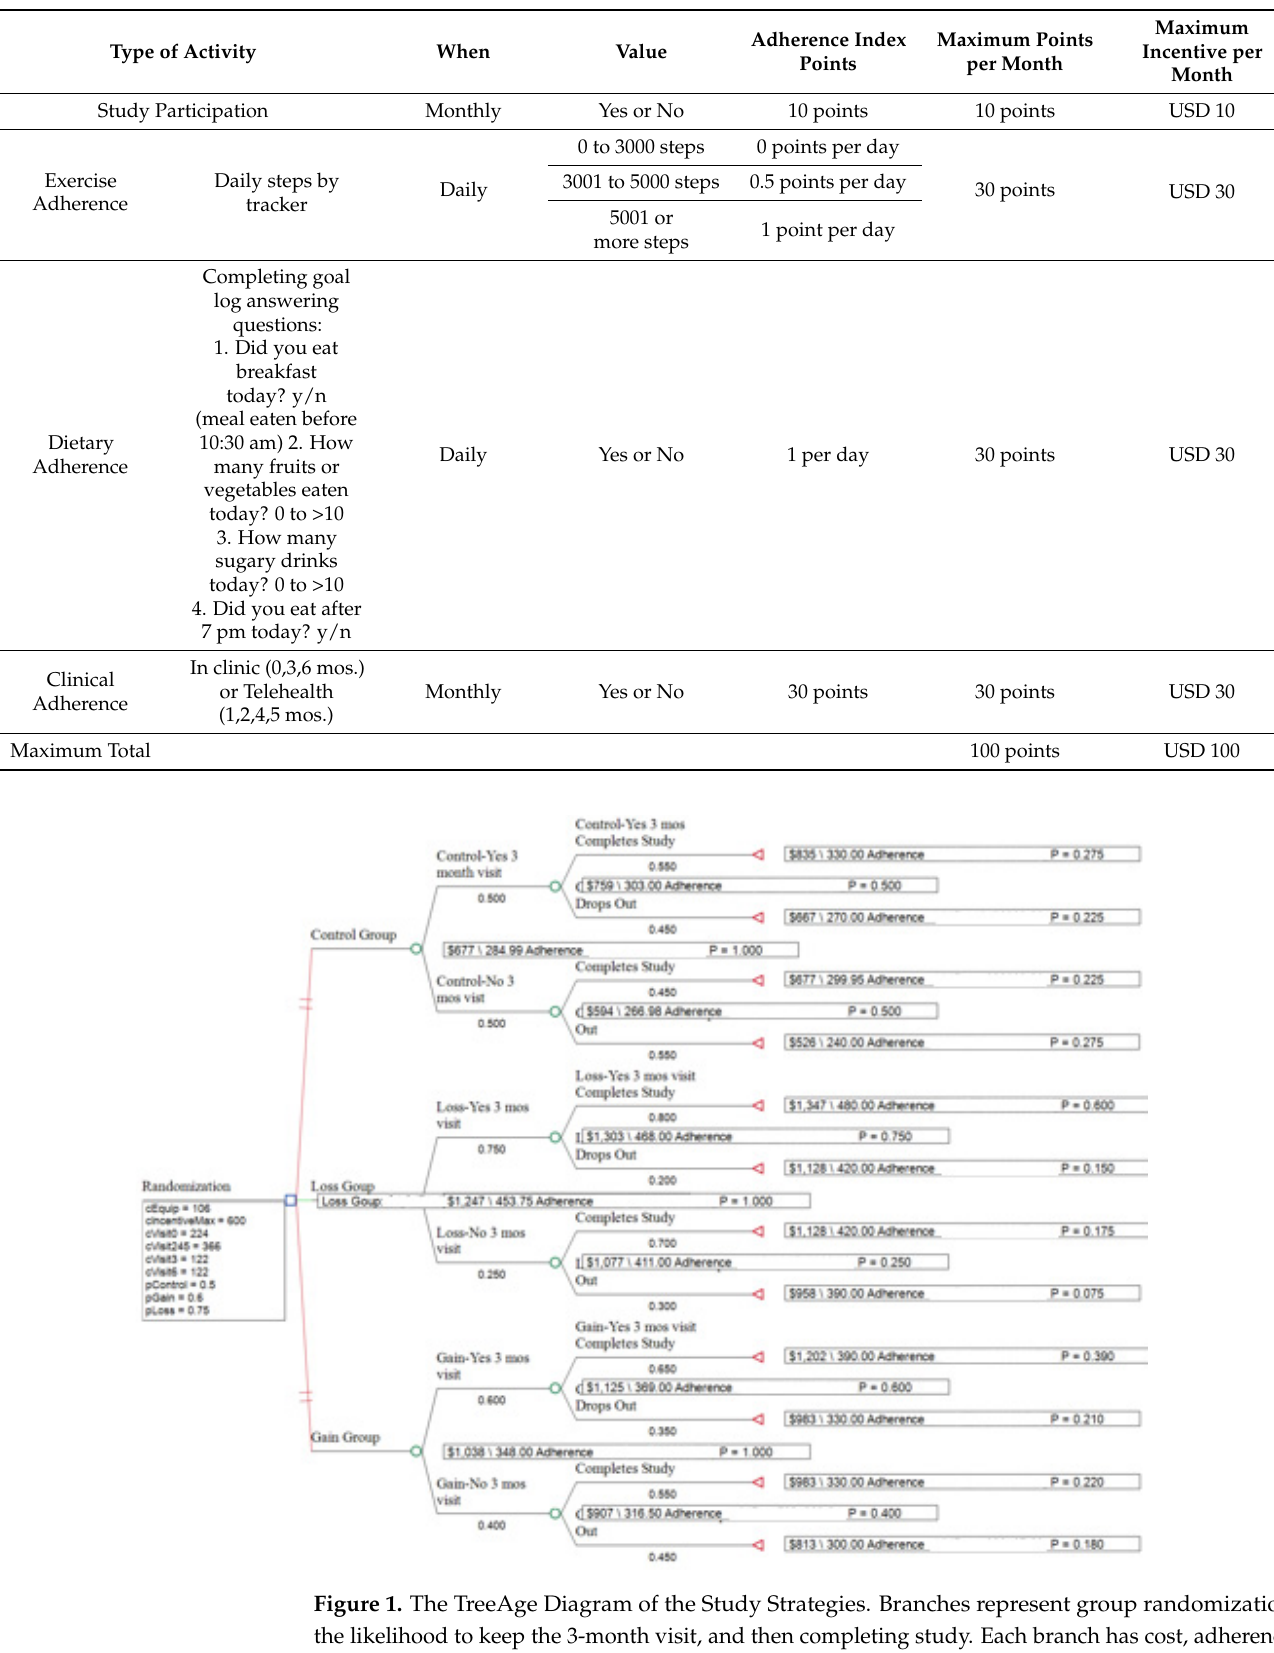
Table 1. Adherence Index/Incentive Scheme.